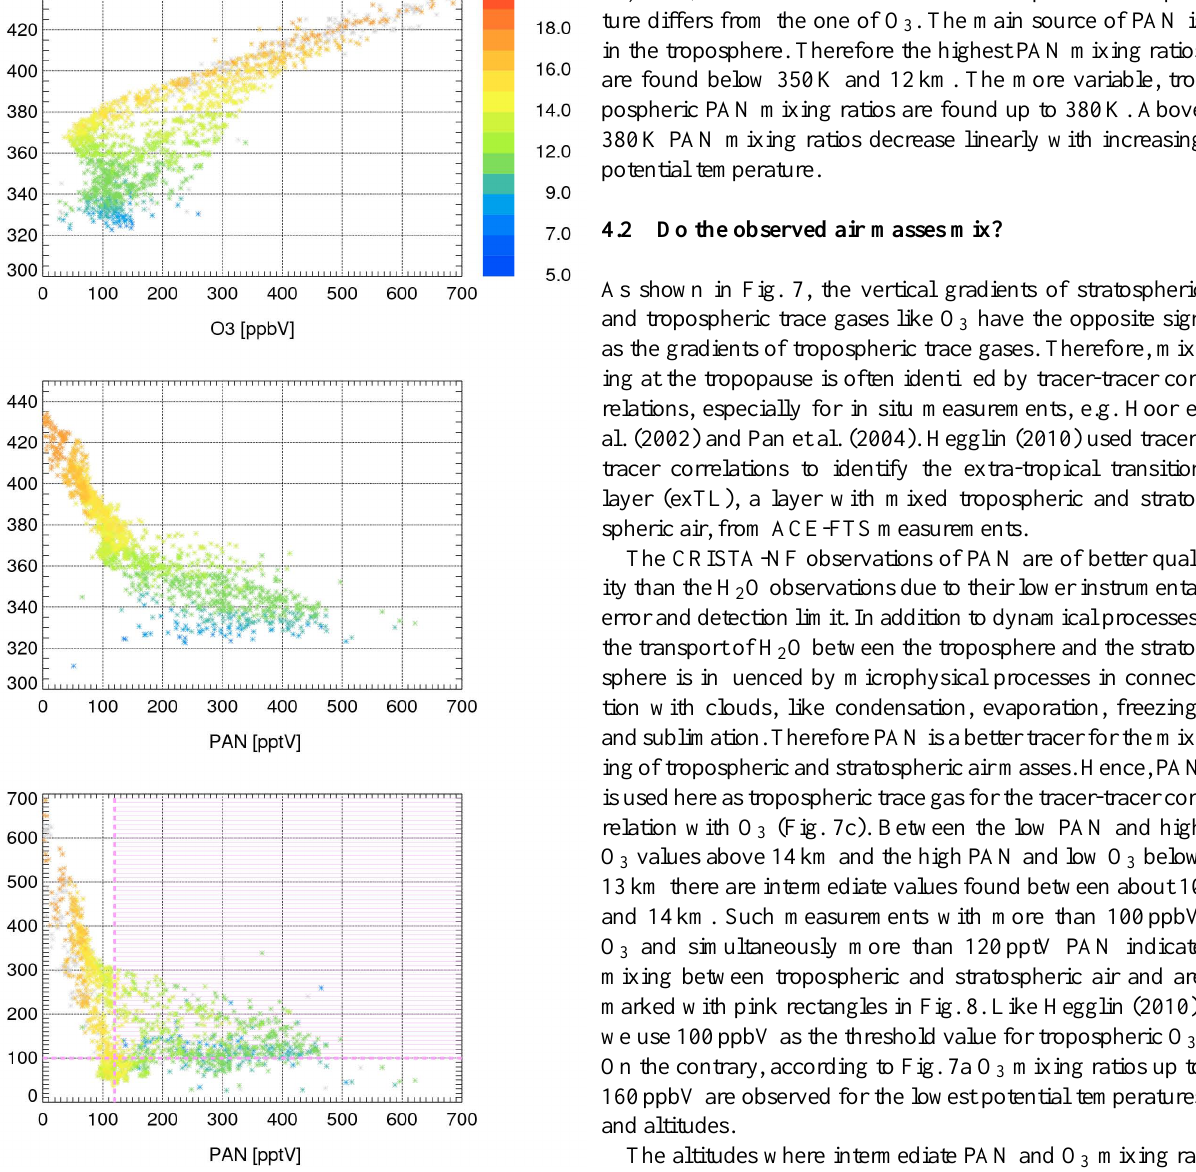
Fig. 7. (a, b) Scatter plot of CRISTA-NF O 3 (a) and PAN (b) against potential temperature. Color scales display the altitude of the mea- sured mixing ratios, grey stars show values, with a vertical resolu- tion coarser then 3km. (c) Scatter plot of CRISTA-NF O 3 and PAN. Pink line shading indicates mixing identified through O 3 mixing ra- tios above 100ppbV at the same time as PAN mixing ratios above